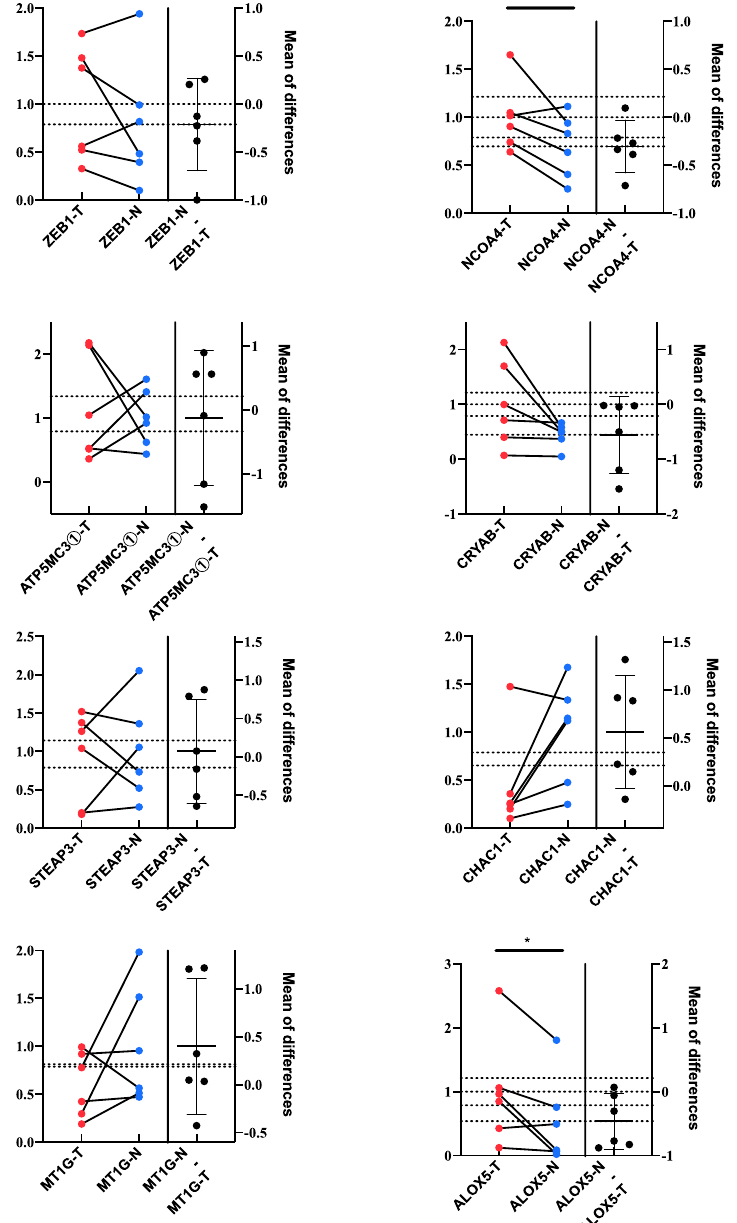
Figure 6. Validation of the crucial genes in the prognostic model. Quantitative real-time polymerase chain reaction (qRT-PCR) of the 8 key genes. *: p < 0.05.